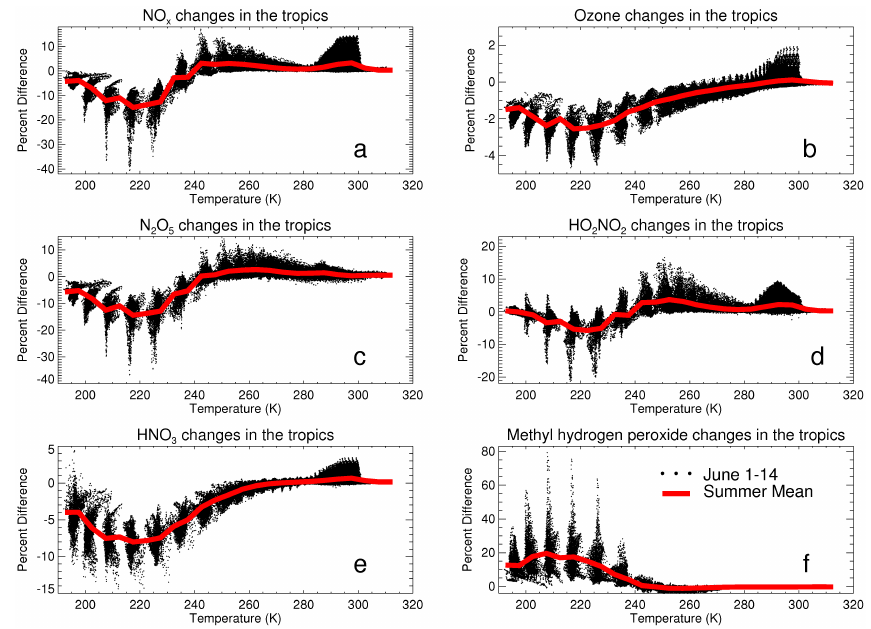
Fig. 6. Differences between the GEOS-Chem base case and MPN case (((MPN-BASE)/BASE)*100) over the tropics versus temperature for (a) NO x , (b) ozone, (c) N 2 O 5 , (d) HO 2 NO 2 , (e) HNO 3 , and (f) methyl hydrogen peroxide. The individual points are the 24h average value of 1–14 June 2008. The red line is the summer mean concentration. The regular temperature intervals at low temperatures are a result of decreasing vertical resolution in the model at increasing altitudes.